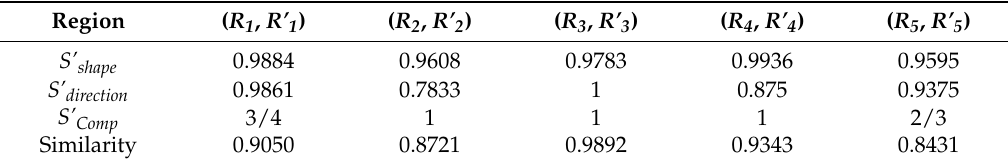
Table 9. The similarities of all matching micro-spatial-scenes in Scenes A and B .